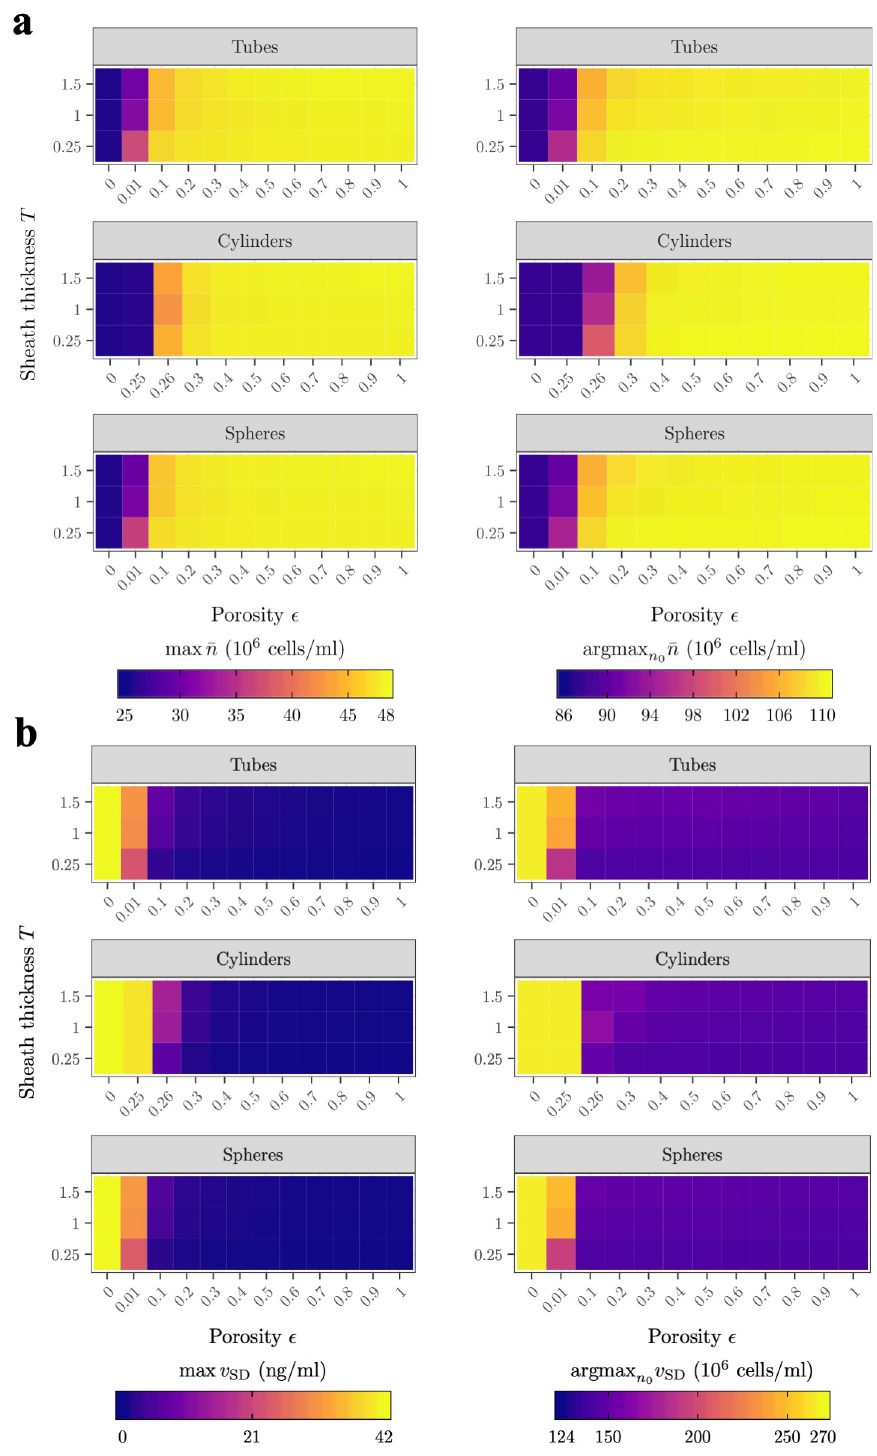
Fig 8. Increasing sheath porosity increases the maximum cell density and decreases the VEGF concentration and gradient field after 24h, regardless of the underlying archetypal porous structure. Increasing sheath thickness has � n � and the associated initial cell density argmax opposite effects. A) max n 0 cell density argmax as functions of sheath porosity � and sheath thickness T for the different tortuosity expressions v n 0 SD listed in Table 1.